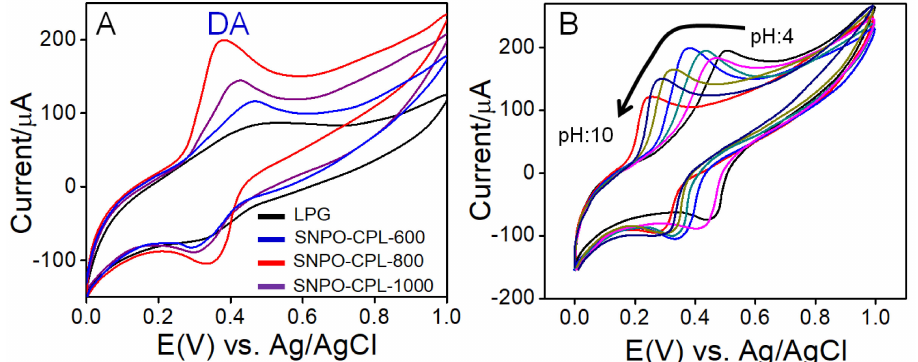
Figure 3. ( A ) CVs of SNPO-CPL-600 (blue line), SNPO-CPL-800 (red line), SNPO-CPL-1000 (purple line), and bare LPG (black line) toward monitoring of 5 µ M of DA in N 2 saturated 0.1 M PBS (pH 7) at scan rate 100 mVs − 1 . ( B ) CV of SNPO-CPL-800 over a pH range of 4 to 10 with scan rate of 100 mVs − 1 in the presence of 5 µ M of